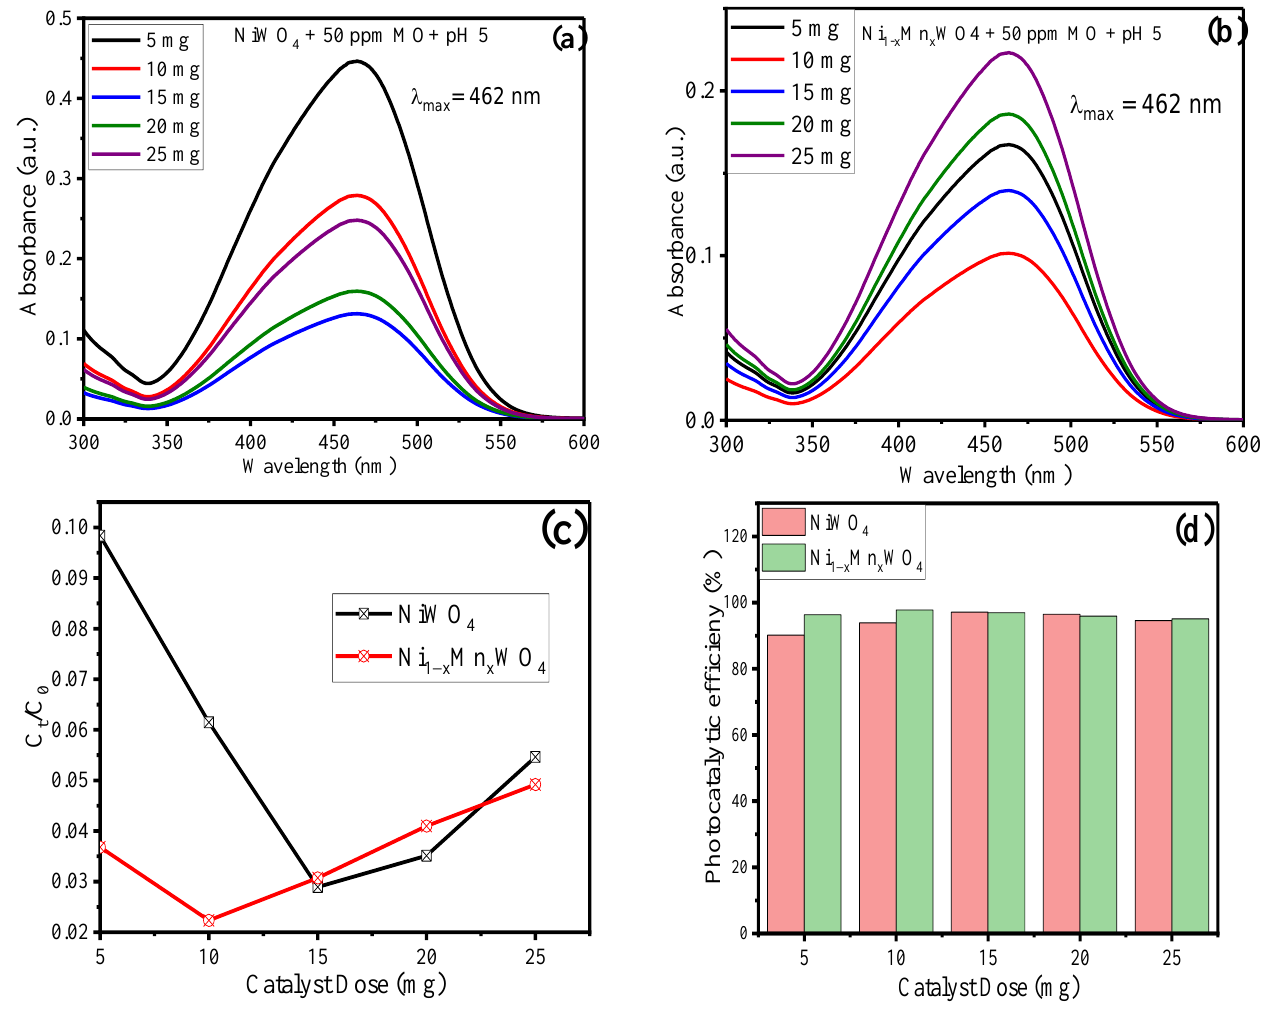
Figure 7. UV–Vis spectra of ( a ) NiWO 4 ( b ) Ni 1 − x Mn x WO 4 NC and ( c ) C t /C 0 graph vs. ( d ) pH depicting rate of MO (50 ppm) degradation for 70 min of visible light